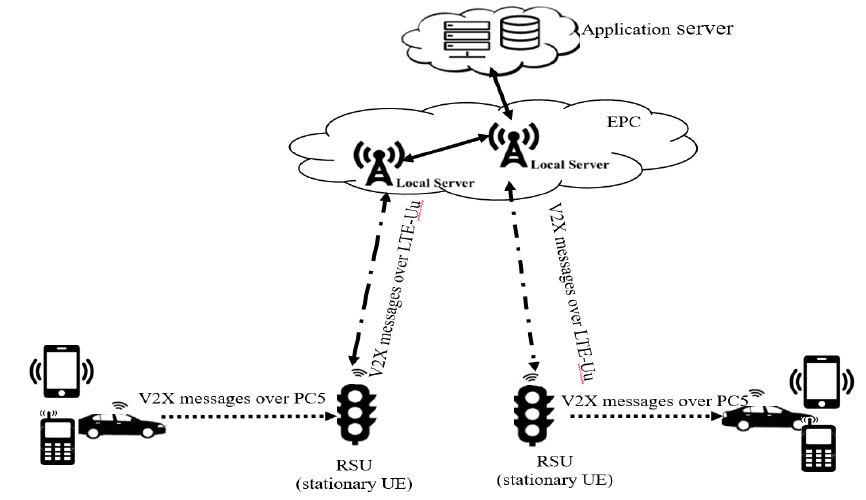
Figure 2. V2X services based on two working modes of cellular